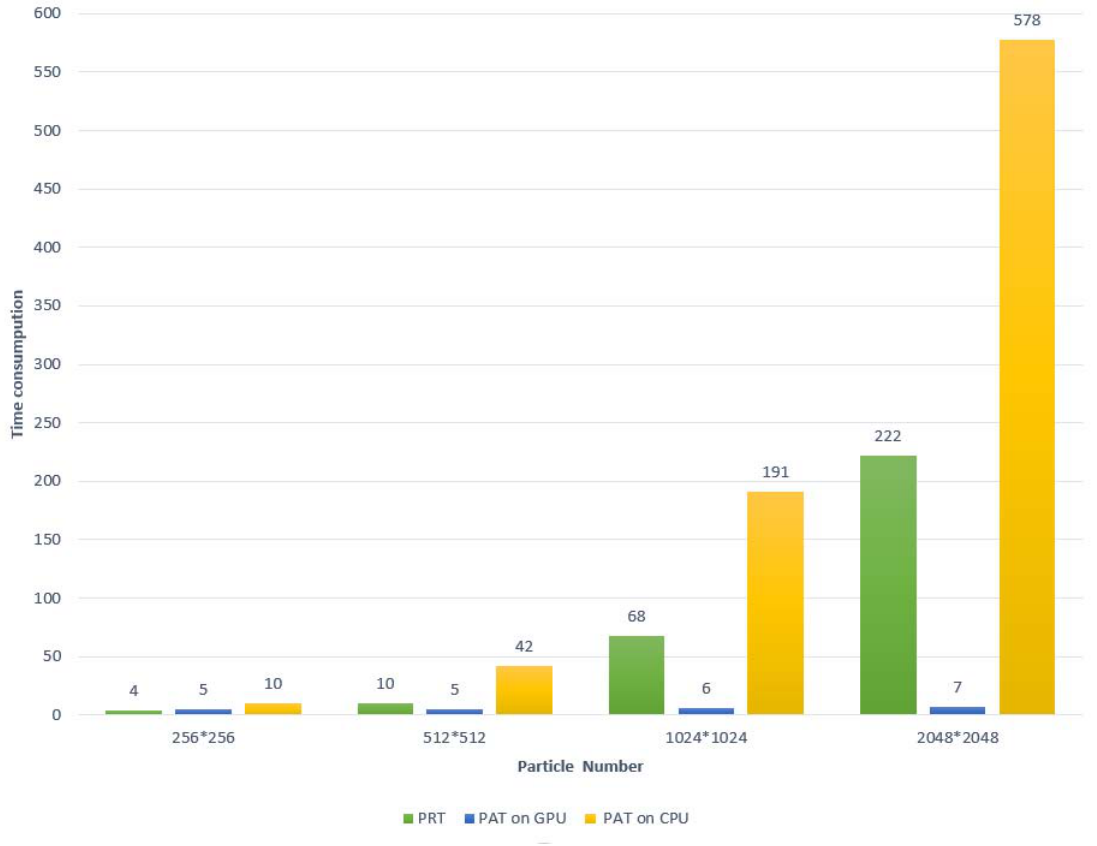
Figure 9. Time consumption of particle advection with different particle